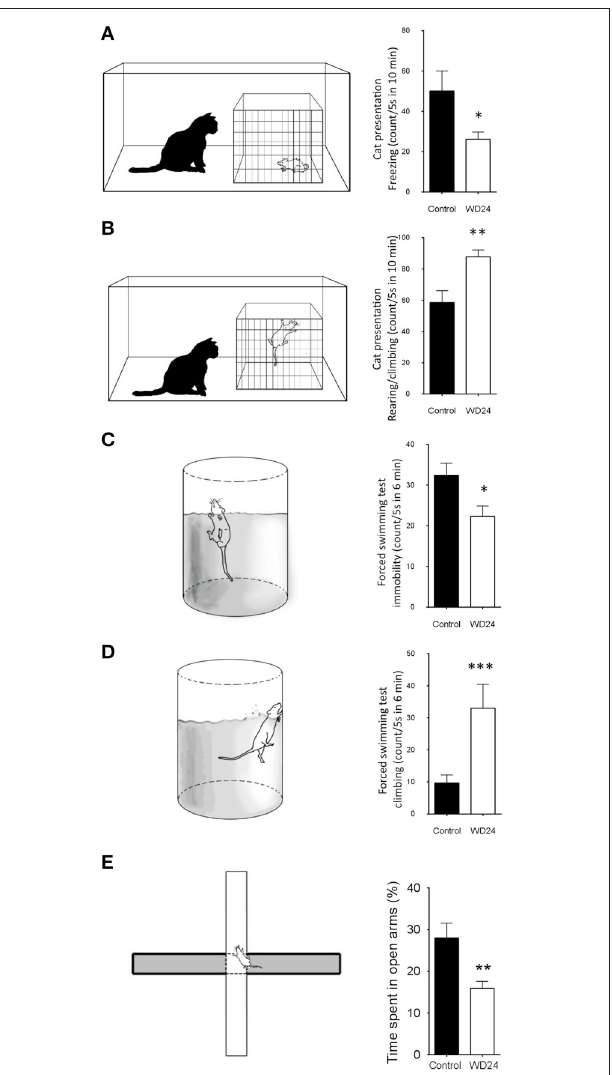
FIGURE 4 | Twenty-four hours of water deprivation (WD24) promoted active stress coping during innate fear processing (cat exposure) and behavioral despair (forced swimming test, FST). WD24 is a potent physiological stimulus to increase metabolic activities of AVP containing magnocellular neurosecretory neurons in SON and PVN. Upon cat exposure, rats expressed innate fear-related passive (freezing), and active (rearing, climbing, and displacement) behaviors (A,B). Rats from WD24 group showed significant reduction of freezing counts (A) and increase of climbing and rearing behaviors (B). Similar observations were obtained during FST for behavioral despair (C,D). For locomotor control, we performed the elevated plus maze (EPM) test to both groups (E). The WD24 rats showed normal locomotion patterns but reduced percentage of time spent in open-arms. (Mean ± SEM, * p < 0.05 , ** p < 0.01 , *** p < 0.001